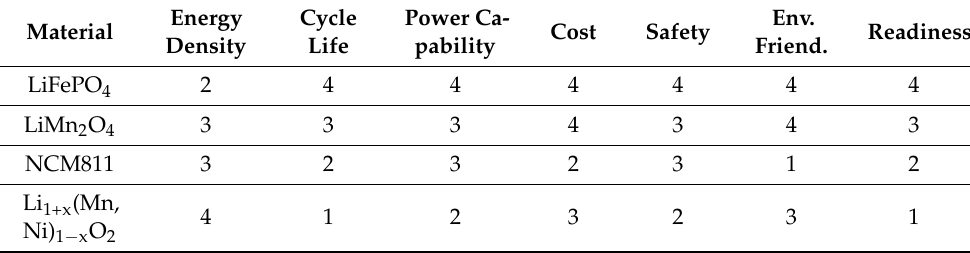
Table 3. Characteristics and evaluation of the different cathode materials presented. The minimum grade is indicated with 1 and the maximum with 4. Env. Friend. refers to Environmental